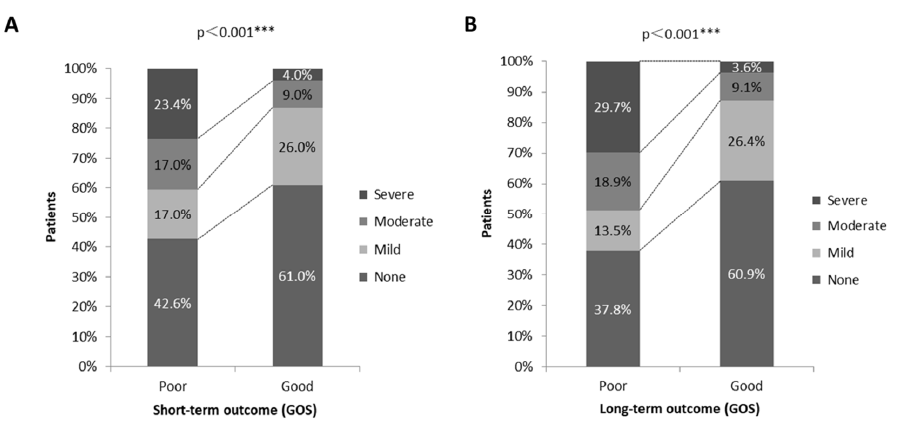
Figure 3. The association of SHV severity and neurologic outcome. Different severity of SHV had statistically significant difference between poor and good outcome for short-term period ( A ) and long-term period ( B ). *** p < 0.001.